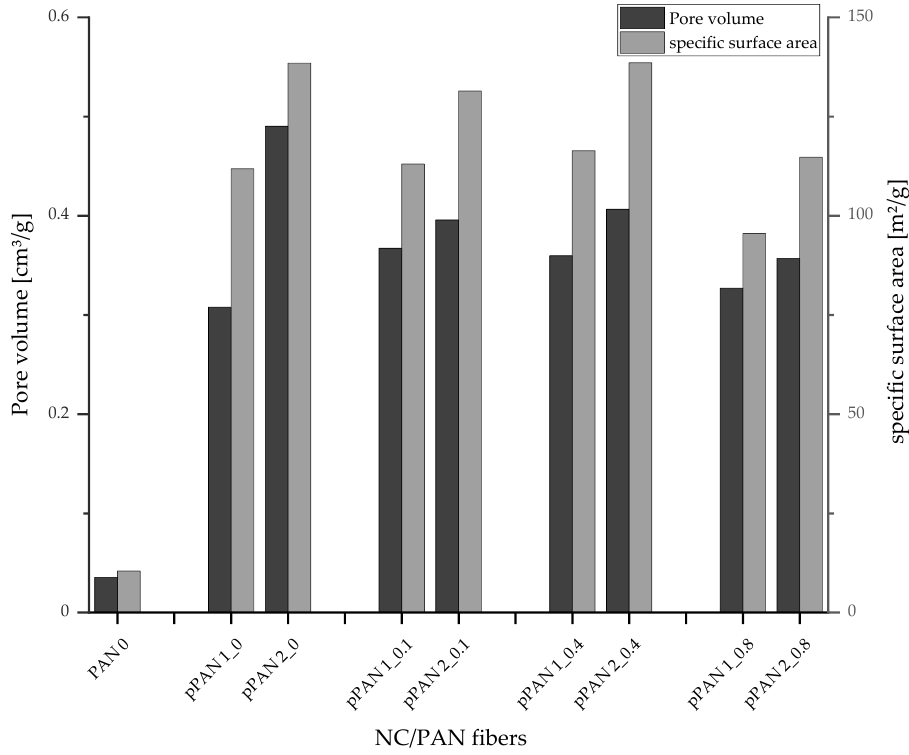
Figure 5. Total pore volume and specific surface area of the developed porous PAN/NC fibers. Comparing the different stretching ratios, there is a difference among the devel- oped porous fibers. The surface area and total pore volume increase more in the case of 100% stretching than in the case of 50% stretching. The higher forces at 100% stretching disturb the fiber coagulation more effectively and force more gaps within the built filament, which leads to a more porous